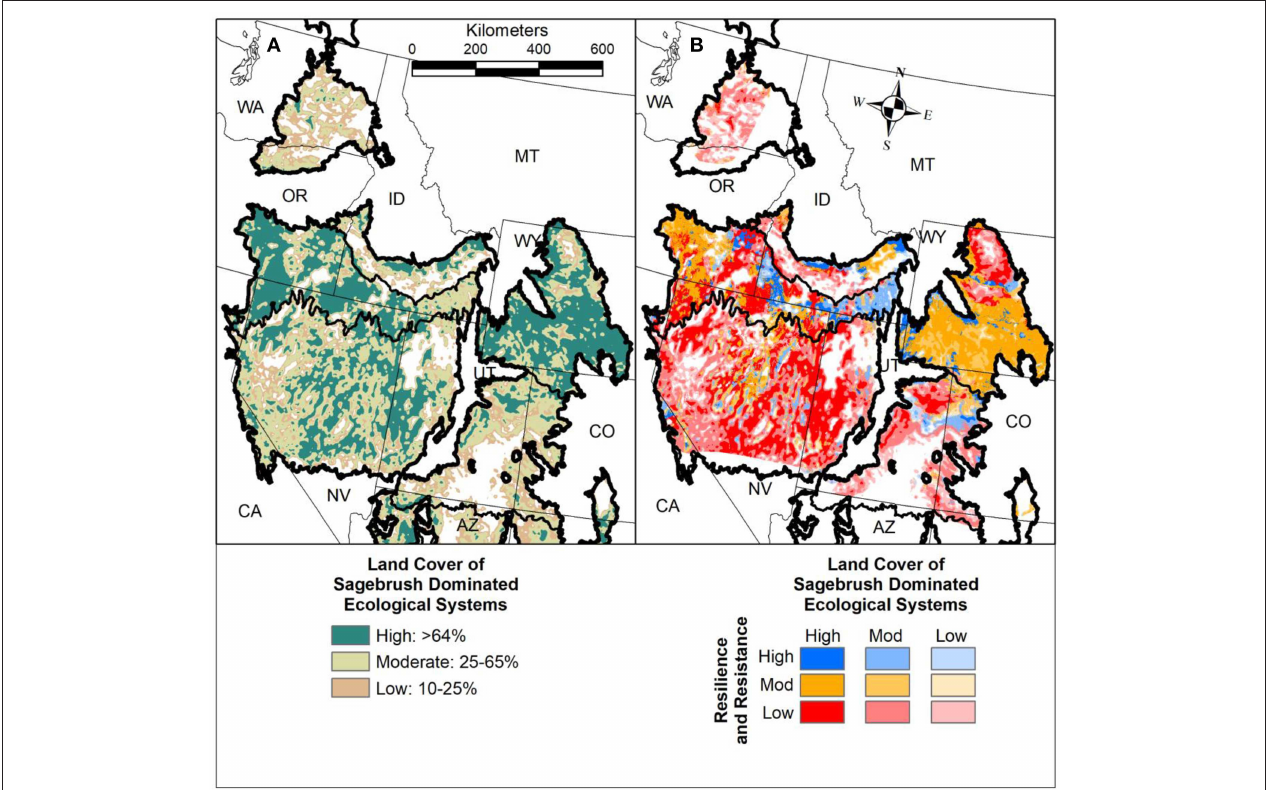
FIGURE 11 | (A) Landscape cover of sagebrush in the Cold Deserts of western North America (low = 10–25%, moderate = 25–65%, high = > 65%) (U.S. Department of the Interior, 2014). Categories of sagebrush landscape cover are based on ecological minimum requirements underlying sage-grouse distributions (Knick et al., 2013; Chambers et al., 2014c). Percentage of sagebrush within each of the categories was determined within a 5km radius of each sagebrush pixel. (B) Landscape cover of sagebrush categories intersected with resilience and resistance categories developed from soil temperature and moisture regimes (Maestas et al., 2016; Chambers et al.,